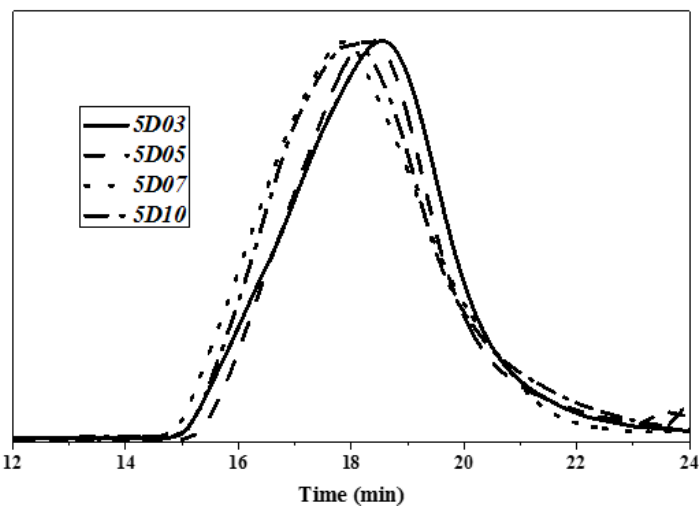
Figure 7. GPC curve of TPU with end-capping agent at concentration of 10 phm.